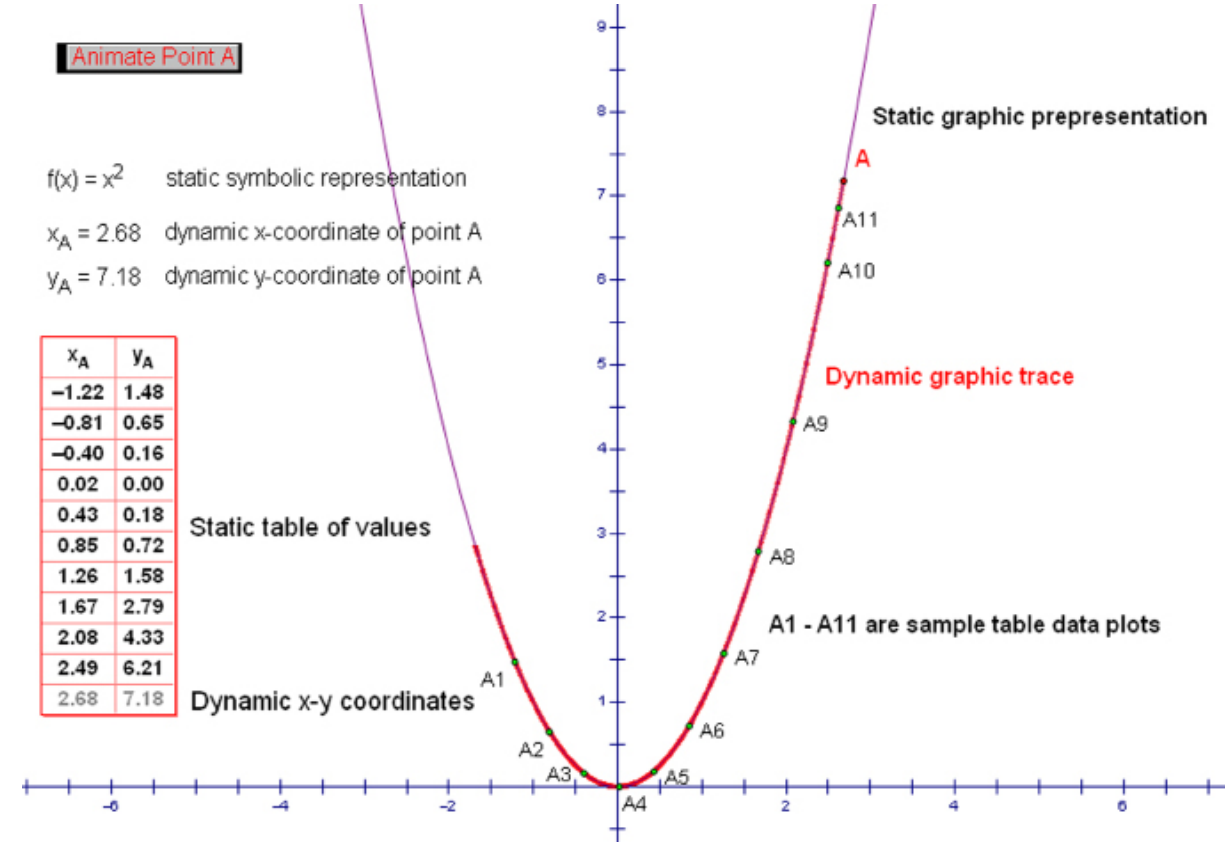
FIGURE 1: Function modelling and simulation in